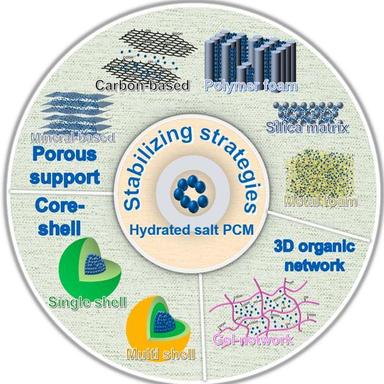
Summary of the stabilizing strategies for hydrated salt PCMs.